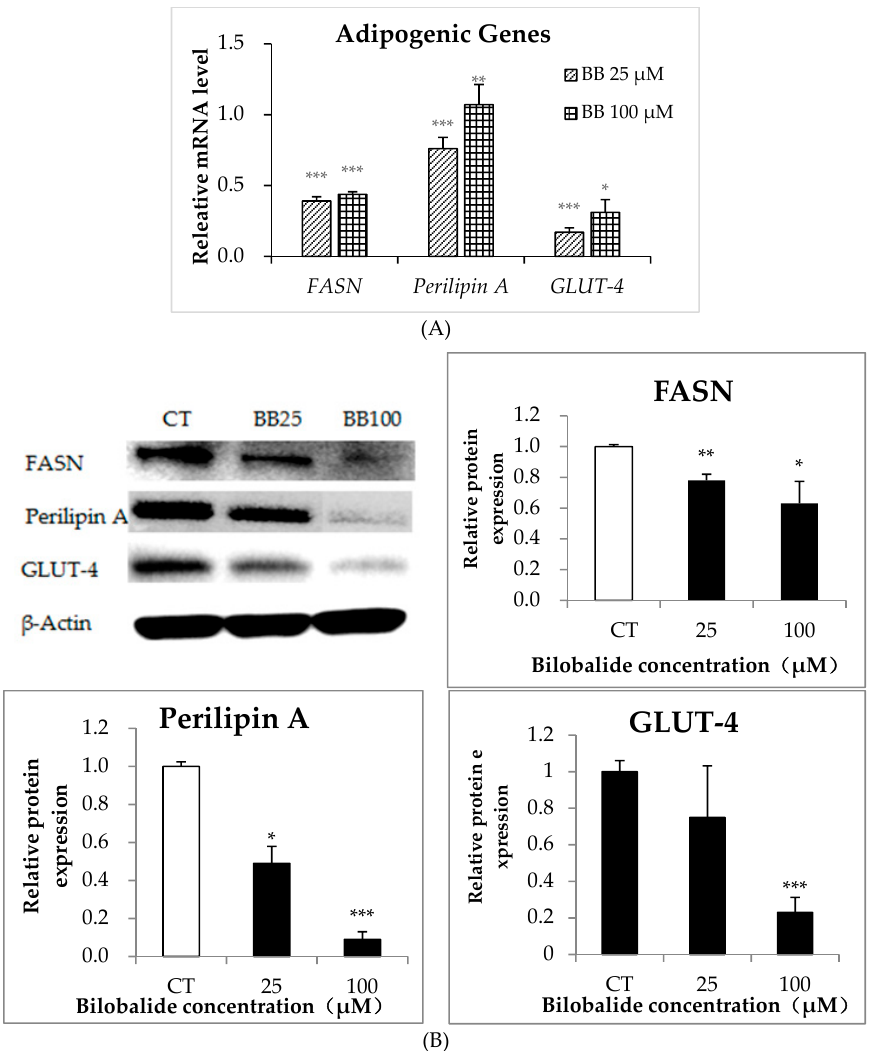
Figure 5. Effects of different bilobalide concentrations on the expression of adipogenic genes. 3T3-L1 cells were cultured 8 days after initiation of differentiation; cells were treated with 0, 25, or 100 μ M bilobalide for 5 days during differentiation. (A) The relative mRNA expression of FASN , perilipin A, and GLUT-4 was quantified by qRT-PCR. (B) Western blot was performed to determine protein levels of the same molecules. Histograms showed quantified levels of band intensities for each protein using Image Lab software. Data represent the mean ± standard deviation (n = 3). * p < 0.05, ** p < 0.01, *** p < 0.001.